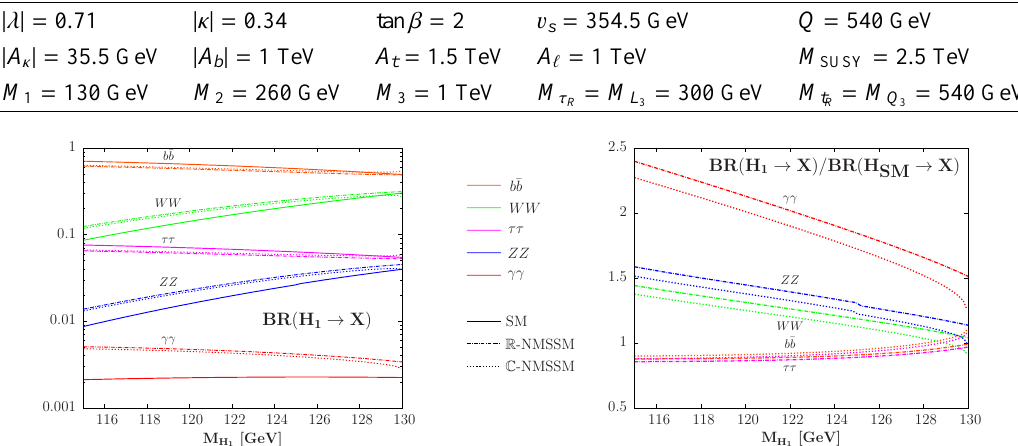
Figure 3. Left: the decay branching fractions of the lightest Higgs state H 1 into b ¯ b (orange line), WW ∗ (green line), τ + τ − (violet line) ZZ ∗ (blue line) and γγ (red line) as a function of the Higgs mass M H (in GeV). The full lines are the SM predictions, the dashed-dotted 1 lines are the R –NMSSM predictions and the dotted lines are the C –NMSSM predictions. Right: the same but for the ratio between the NMSSM and the SM branching fractions.